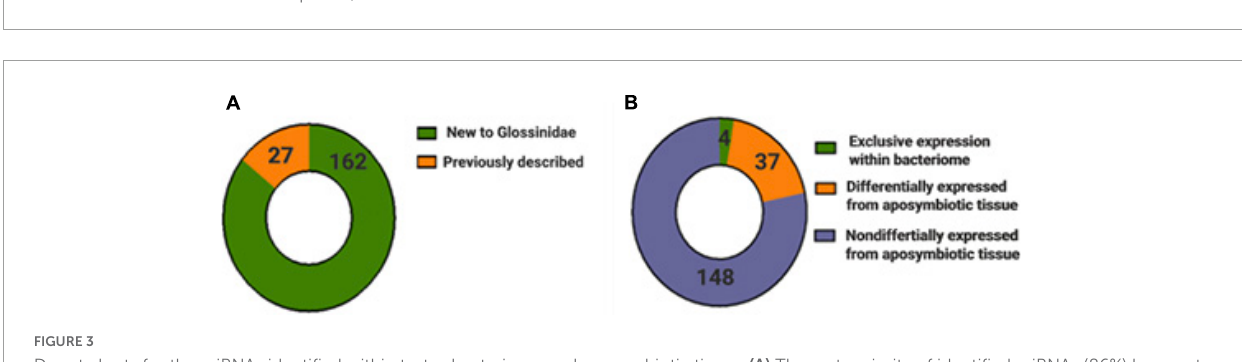
FIGURE2 COGs assignments acquired from eggNOG 5.0. A total of 15 COG assignments are predicted for the 21 differentially expressed mRNAs between virgin and mated bacteriomes of G. morsitans with some mRNAs receiving multiple COG assignments. An enrichment of COG assignments in metabolism and transport functions (P, E, F, G, H, and I, noted with red bars) is observed for these mRNAs, with nearly half of these (47%) involved in amino acid metabolism and transport. S, Function unknown is not included.